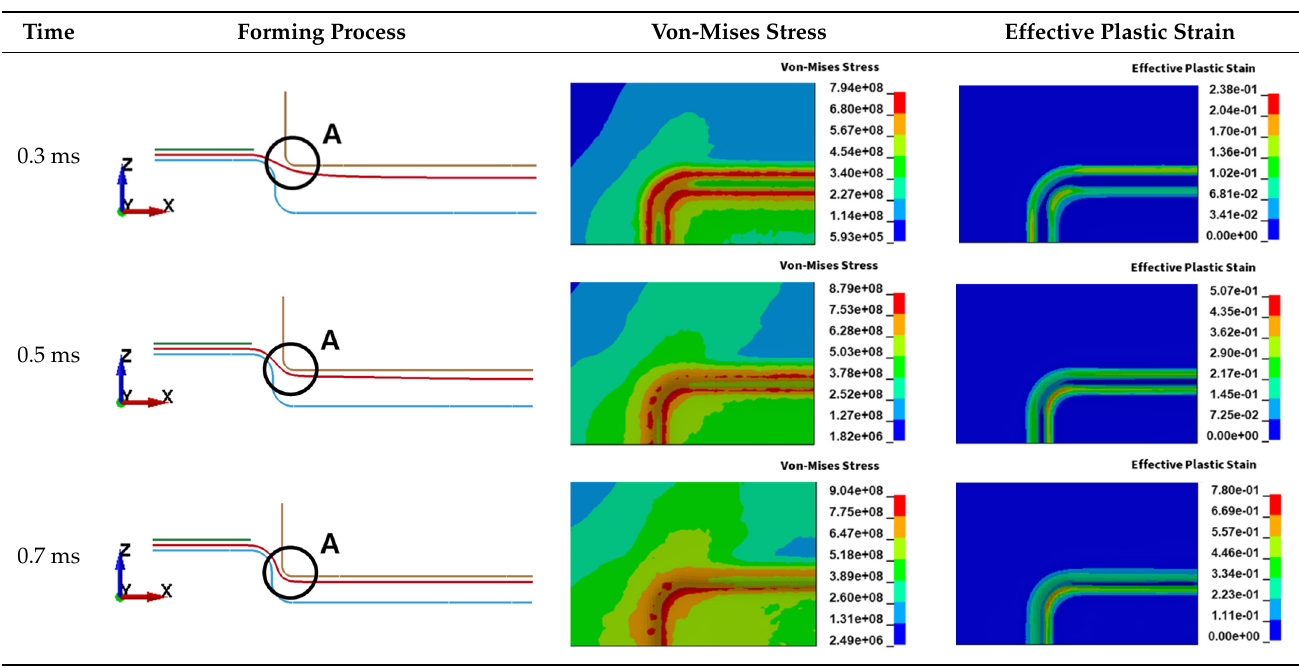
Figure 6. Distance between sheet and die (forming accuracy) for ( a ) CASE 1, ( b ) CASE 2, ( c ) CASE 3, and ( d ) CASE 4. Table 4. Von Mises stress and effective plastic strain distribution diagram corresponding to the Table 4. Von Mises stress and effective plastic strain distribution diagram corresponding to the Table 4. Von Mises stress and effective plastic strain distribution diagram corresponding to the Table 4. Von Mises stress and effective plastic strain distribution diagram corresponding to the Table 4. Von Mises stress and effective plastic strain distribution diagram corresponding to the Table 4. Von Mises stress and effective plastic strain distribution diagram corresponding to the Table 4. Von Mises stress and effective plastic strain distribution diagram corresponding to the Table 4. Von Mises stress and effective plastic strain distribution diagram corresponding to the Table 4. Von Mises stress and effective plastic strain distribution diagram corresponding to the Table 4. Von Mises stress and effective plastic strain distribution diagram corresponding to the drawing process (CASE 1, depth 5 drawing process (CASE 1, depth 5 mm). drawing process (CASE 1, depth 5 mm). drawing process (CASE 1, depth 5 mm). drawing process (CASE 1, depth 5 mm). drawing process (CASE 1, depth 5 mm). drawing process (CASE 1, depth 5 mm). drawing process (CASE 1, depth 5 mm). drawing process (CASE 1, depth 5 mm). drawing process (CASE 1, depth 5 mm).